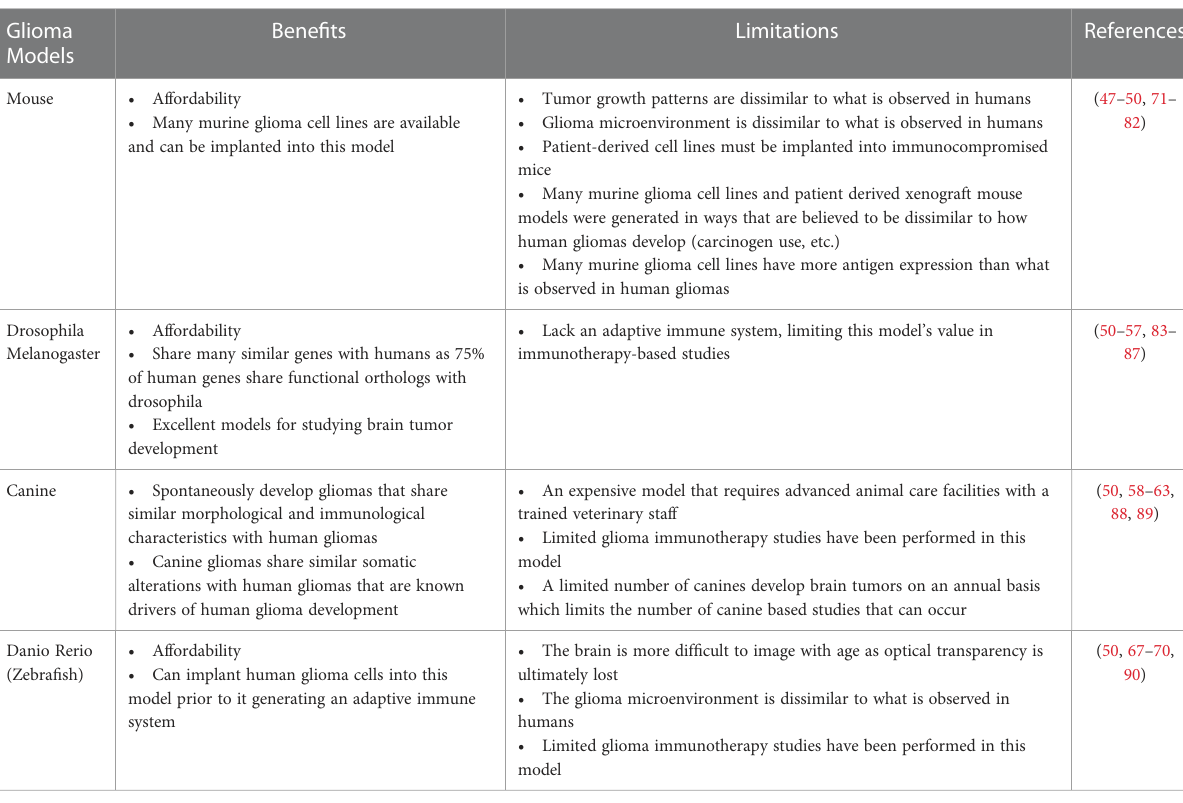
TABLE 1 Bene fi ts and limitations associated with animal models of